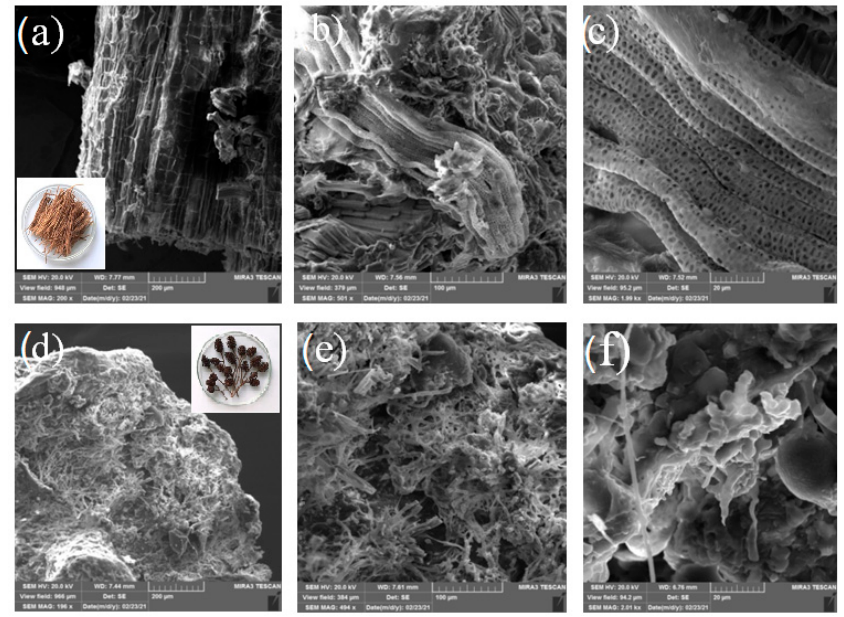
Figure 5. FESEM micrographs at different magnifications of P_RS ( a ) 200× (inset: visual appearance), ( b ) 500×, and ( c ) 2000×; and A_RS ( d ) 200× (inset: visual appearance) and ( e ) 500×, ( f ) 2000×.